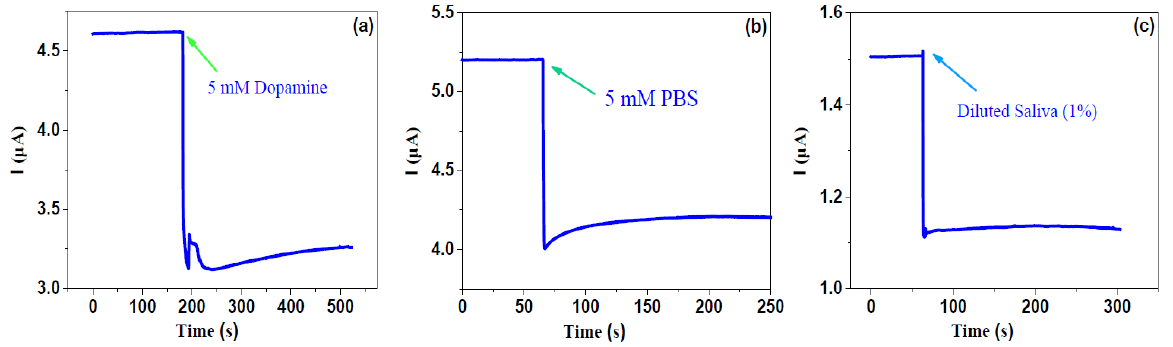
Figure 3. Response for 5 mM PBS, 5 mM dopamine and 1% diluted saliva solution.